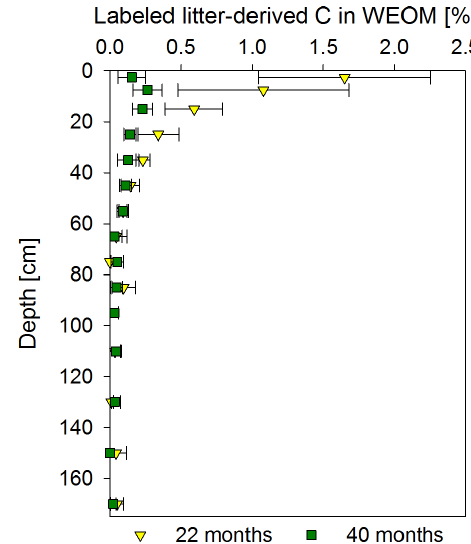
Figure 7. Mean proportion of litter-derived C in water extractable organic OM (WEOM) in percentage of the initial label input for both sampling times, 22 and 40 months after labeled litter applica- tion, with soil depth ( n = 3; error bars represent the standard de- viation). According to ANOVA tests, significant changes between both samplings were only present in the 0–5 and 10–20cm incre- ments ( p < 0 . 05). Significant differences between soil increments were only present for the topsoil increments compared to all subsoil increments for each sampling